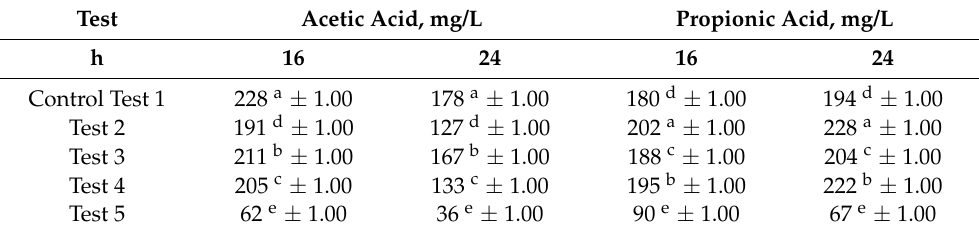
Table 6. Volatile fatty acid concentrations at 16 and 24 h of incubation (in brackets the percentage difference compared to the Control test 1 are reported). Different letters in the same column denote significant differences (a,b,c,d,e p ≤